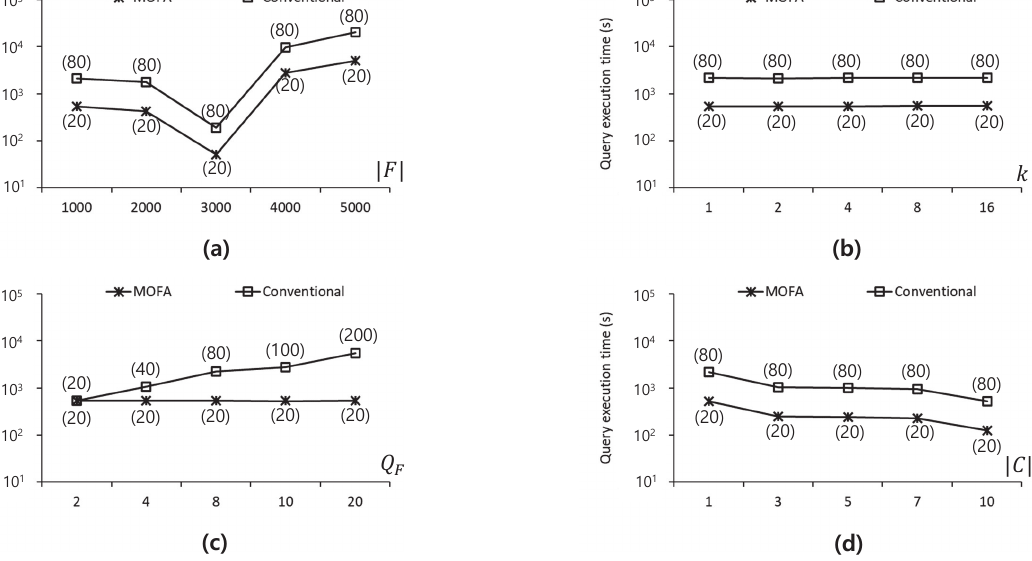
Figure 16. Performance comparisons between MOFA and the conventional algorithm on the SF